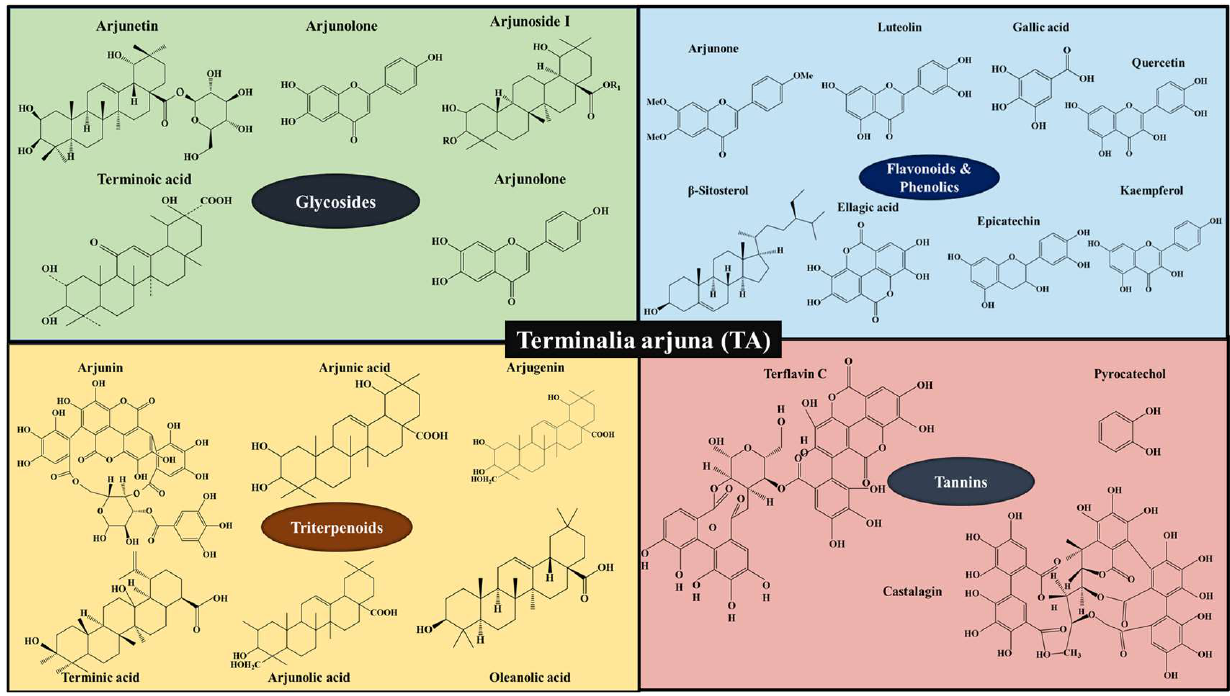
Figure 1. Major phytochemicals of TA used in biomedical applications.